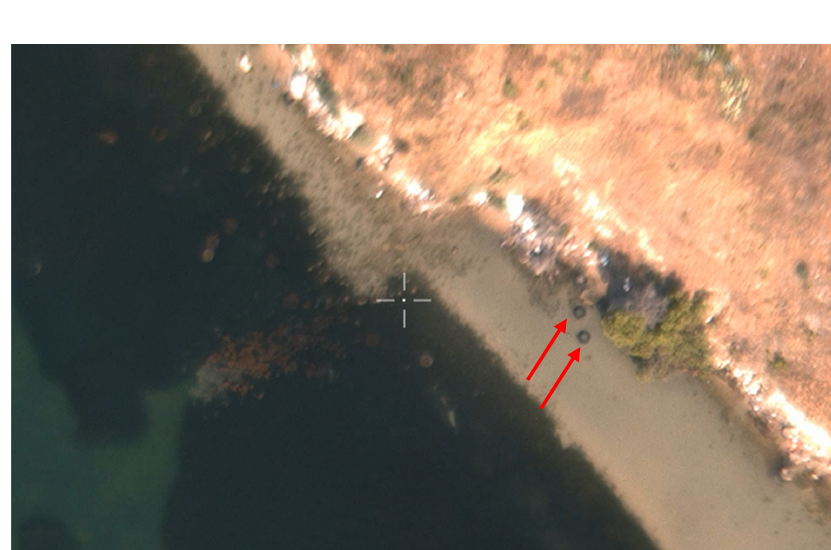
Remote Sens. 2021 , 13 , x FOR PEER REVIEW Figure 15. Illegal fishing net. Figure 15. Illegal fishing net.